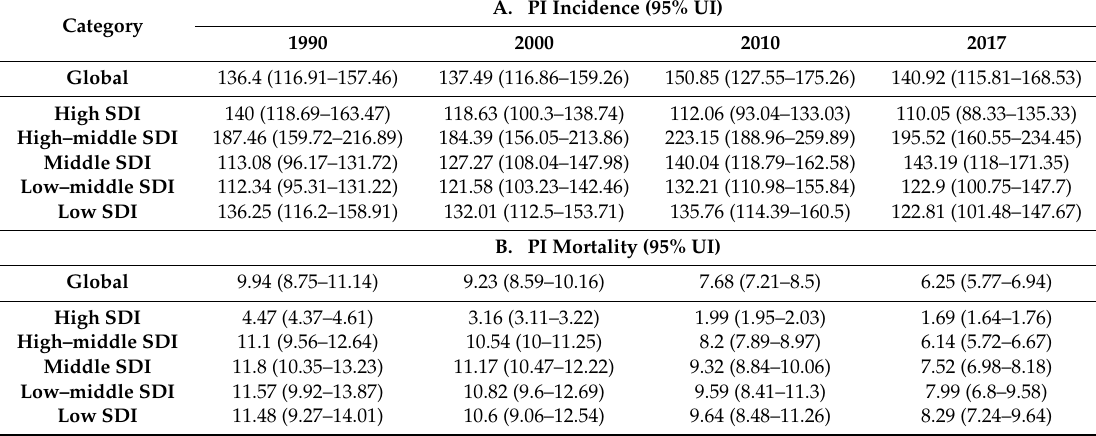
Table 1. Incidence (A) and mortality rate (B) for pedestrian road tra ffi c injuries (PIs) 1990–2017.